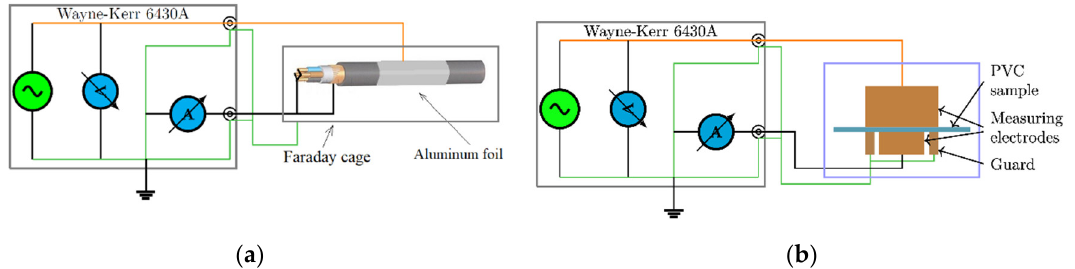
Figure 3. The measurement of tan δ by impedance analyzer: ( a ) measurement of cable samples in a Faraday cage; ( b ) measurement of PVC films by guarded electrode setup.